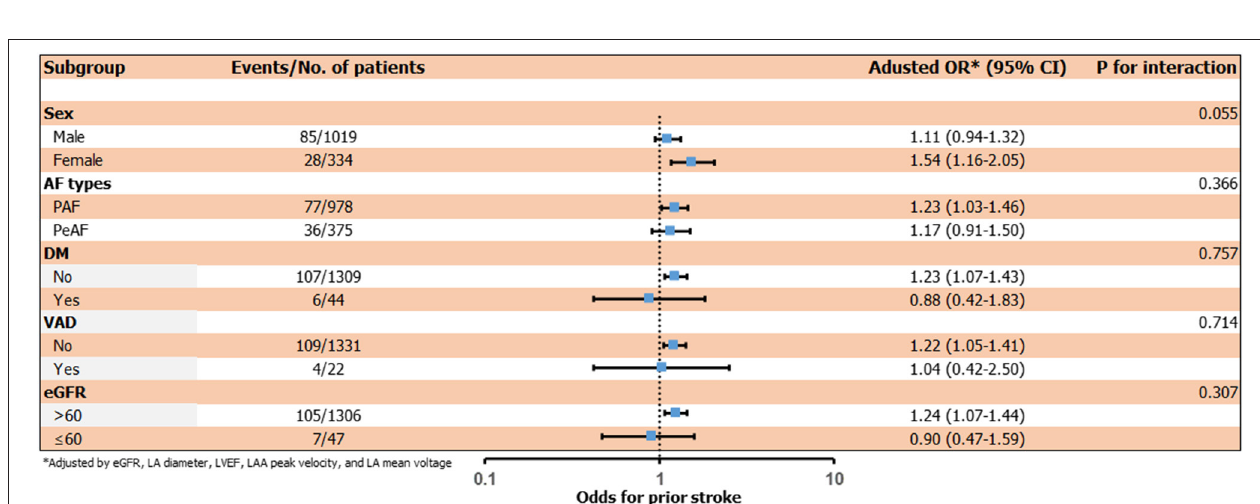
FIGURE 2 | Odds for prior stroke based on the individual factors of H 2 FPEF score.